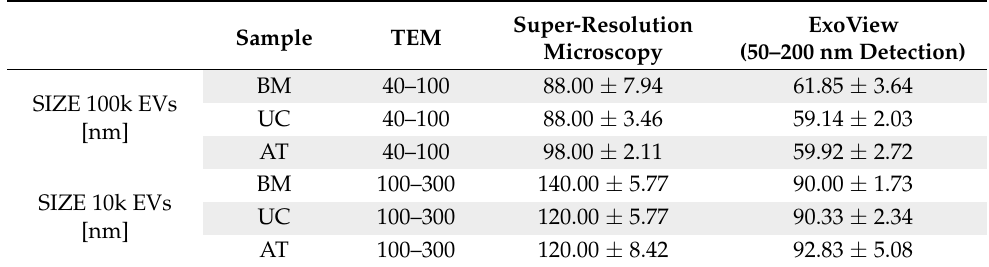
Table 2. Mean size of EVs measured by transmission electron microscopy, super-resolution mi- croscopy and